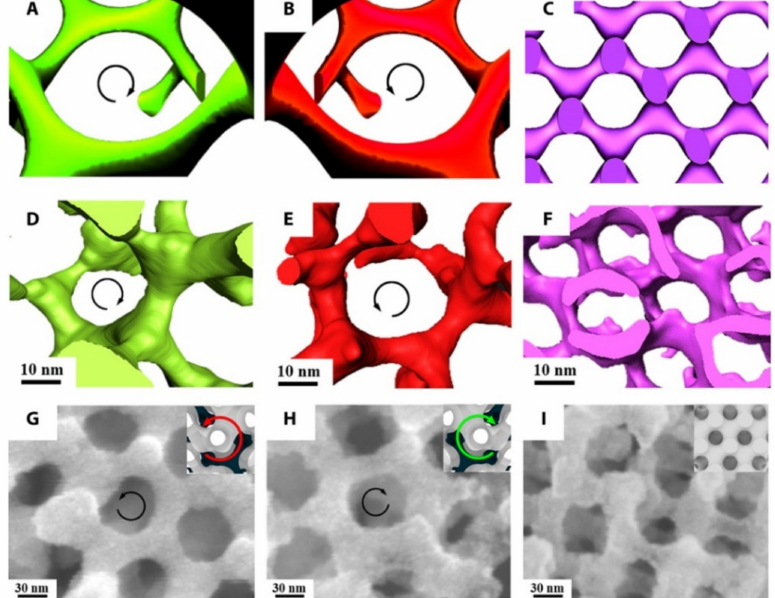
Figure 13. 3D imaging of a PI network and SEM images of a Ni network fabricated from templating a polylactide network. ( A – C ) Simulated images and ( D – F ) 3D reconstructions from electron tomog- raphy of PI-b-PS-b-PLLA, PI-b-PS-b-PDLA, and PI-b-PS-b-PLA, respectively. Direct visualization of the right-handed [112] helical locus of the PI network in ( A ) and ( D ) and the left-handed helical locus of the PI gyroid network in ( B ) and ( E ). When an achiral PLA block is used, the structure is an achiral diamond ( F ). ( G – I ) FESEM images of the Ni network from PI-b-PS-b-PLLA, PI-b-PS-b-PDLA, and PI-b-PS-b-PLA, respectively, at which the Ni network takes on the handedness and volume fraction of the particular polylactide block that is hydrolyzed. Insets show the corresponding sim- ulated structures with dark core struts as a visual guide. Direct visualization of the Ni gyroid network along the [111] direction demonstrates a left-handed locus in PI-b-PS-b-PLLA ( G ) and right-handed helical locus in PI-b-PS-b-PDLA ( H ). Reproduced from [114], under the terms of